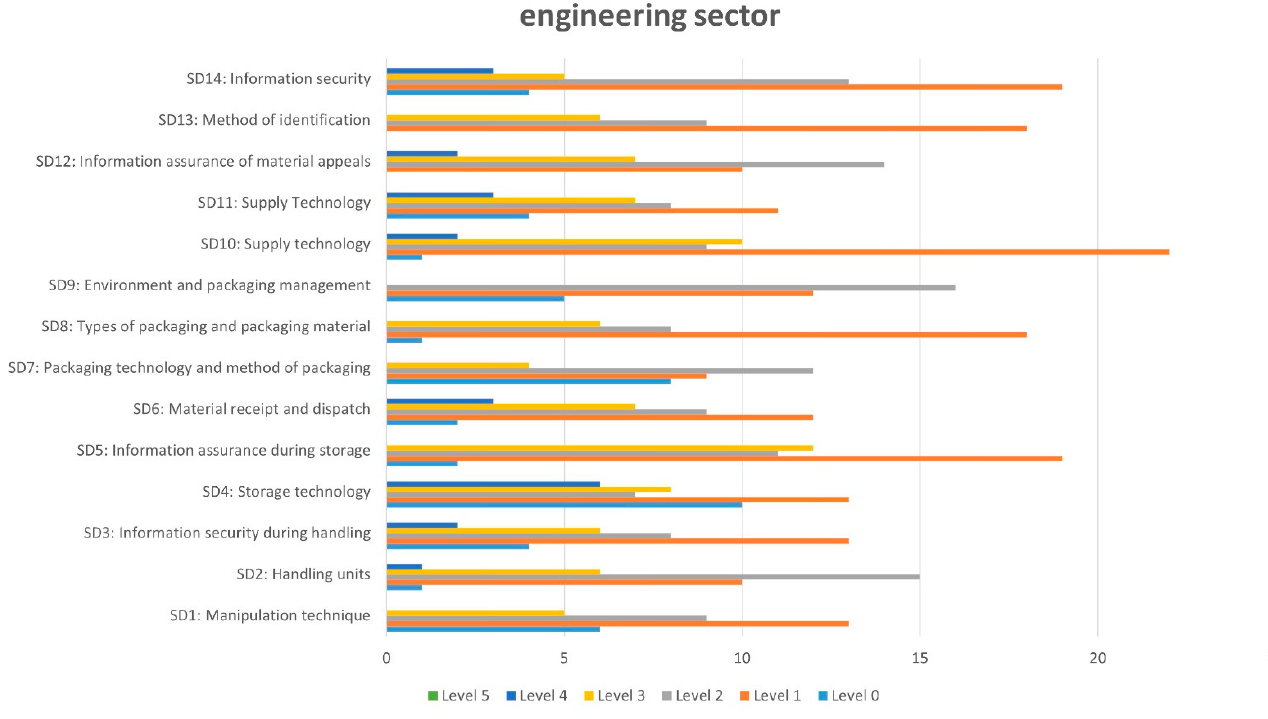
Figure 12. Total number of occurrences of level values for subdimensions—mechanical engineer- ing .